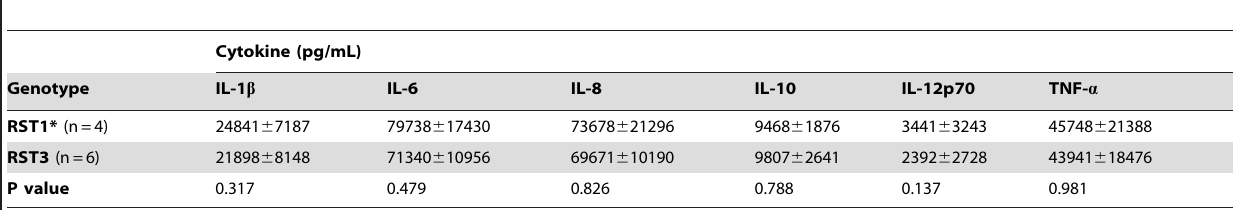
Table 2. Pro- and anti-inflammatory cytokine production by RST1 and RST3 B. burgdorferi clinical